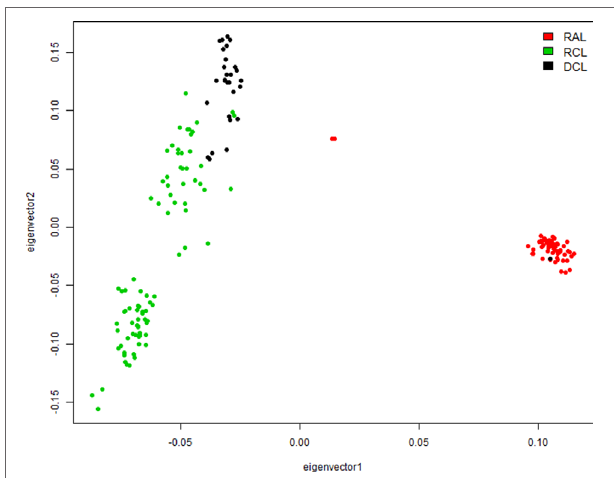
FIGURE 3 | Population structure identified by the principal component analysis (PCA). DCL, RAL, and RCL represent dark comb line, random line, and red comb line chickens, respectively.